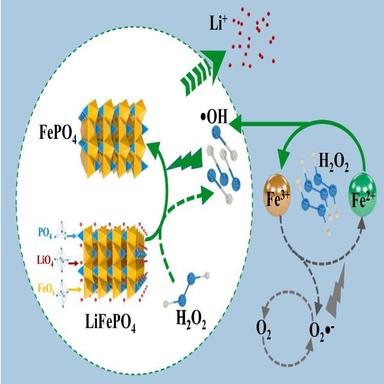
Schematic illustration of the detailed transformation of different products for the in-situ recycling of FePO4 and Li+ by advanced oxidation metallurgy.